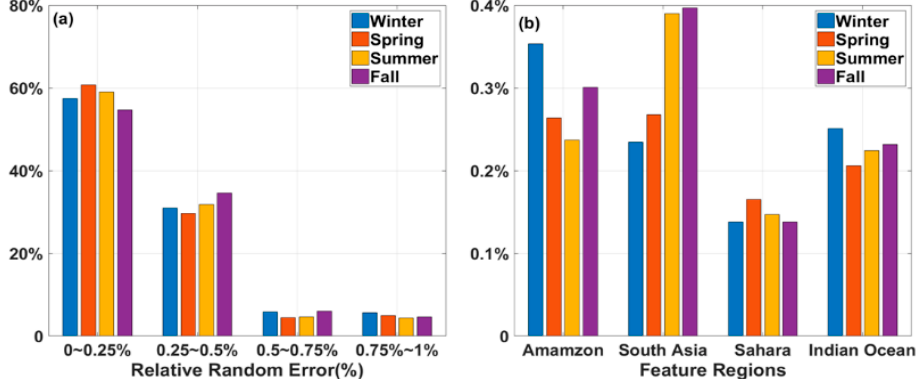
Figure 7. ( a ) The statistical distribution of the global seasonal RREs of AC-IPDA lidar from December 2015 to November 2016. ( b ) The RREs results of four feature regions: Amazon, South Asia, Sahara, and Indian Ocean.